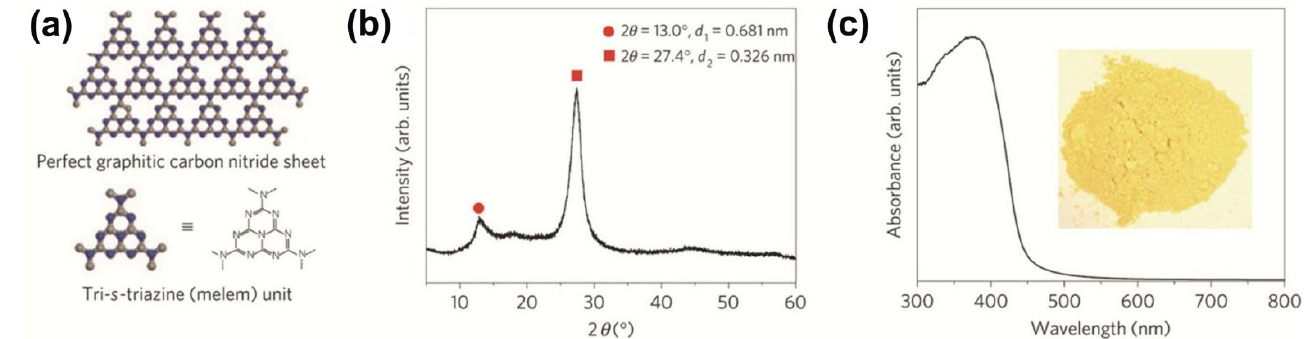
Figure 5. Crystal structure and optical properties of graphitic carbon nitride: ( a ) Schematic diagram of a perfect graphitic carbon nitride sheet constructed from melem units, ( b ) Experimental XRD pattern of the polymeric carbon nitride, revealing a graphitic structure with an interplanar stacking distance of aromatic units of 0.326 nm and ( c ) Ultraviolet-visible diffuse reflectance spectrum of the polymeric carbon nitride. Inset: Photograph of the photocatalyst. (Reproduced with permission from [72], copyright 2009, Springer Nature).